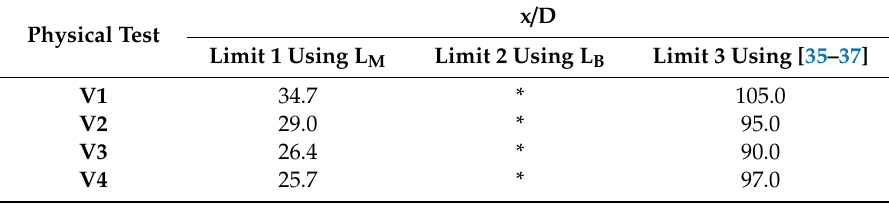
Table 5. Summary of the limits of positively buoyant jet zones defined by other